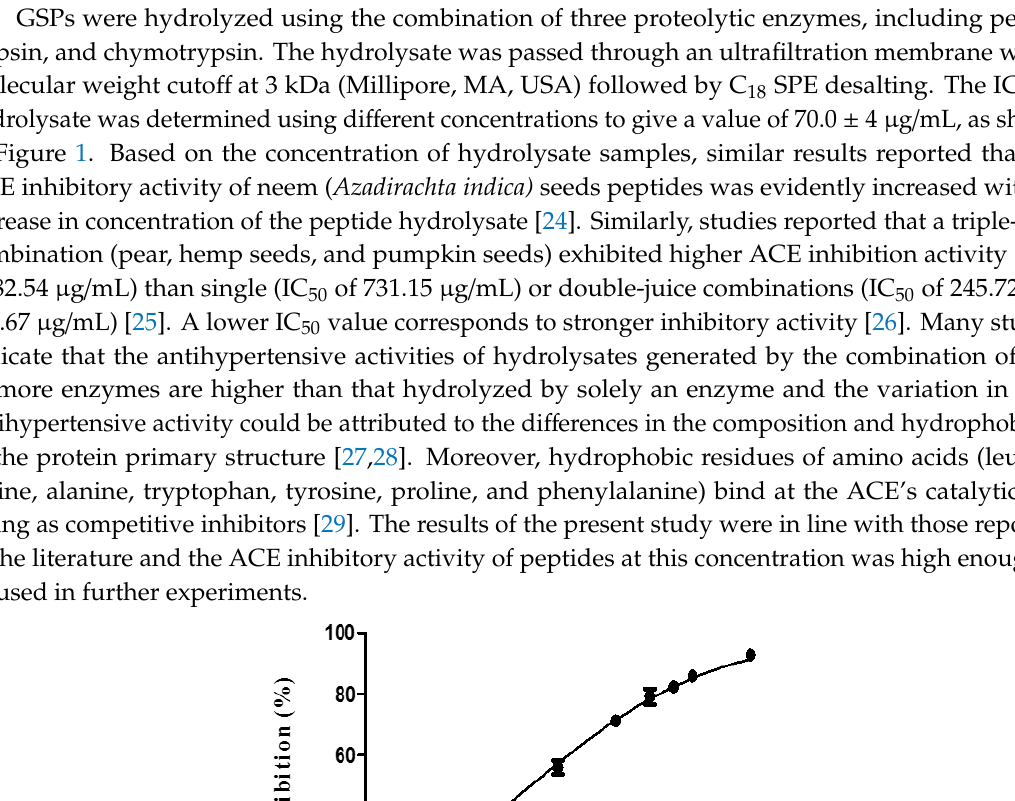
Figure 1. IC 50 value of gac seed proteins (GSPs) hydrolysate (<3 kD).